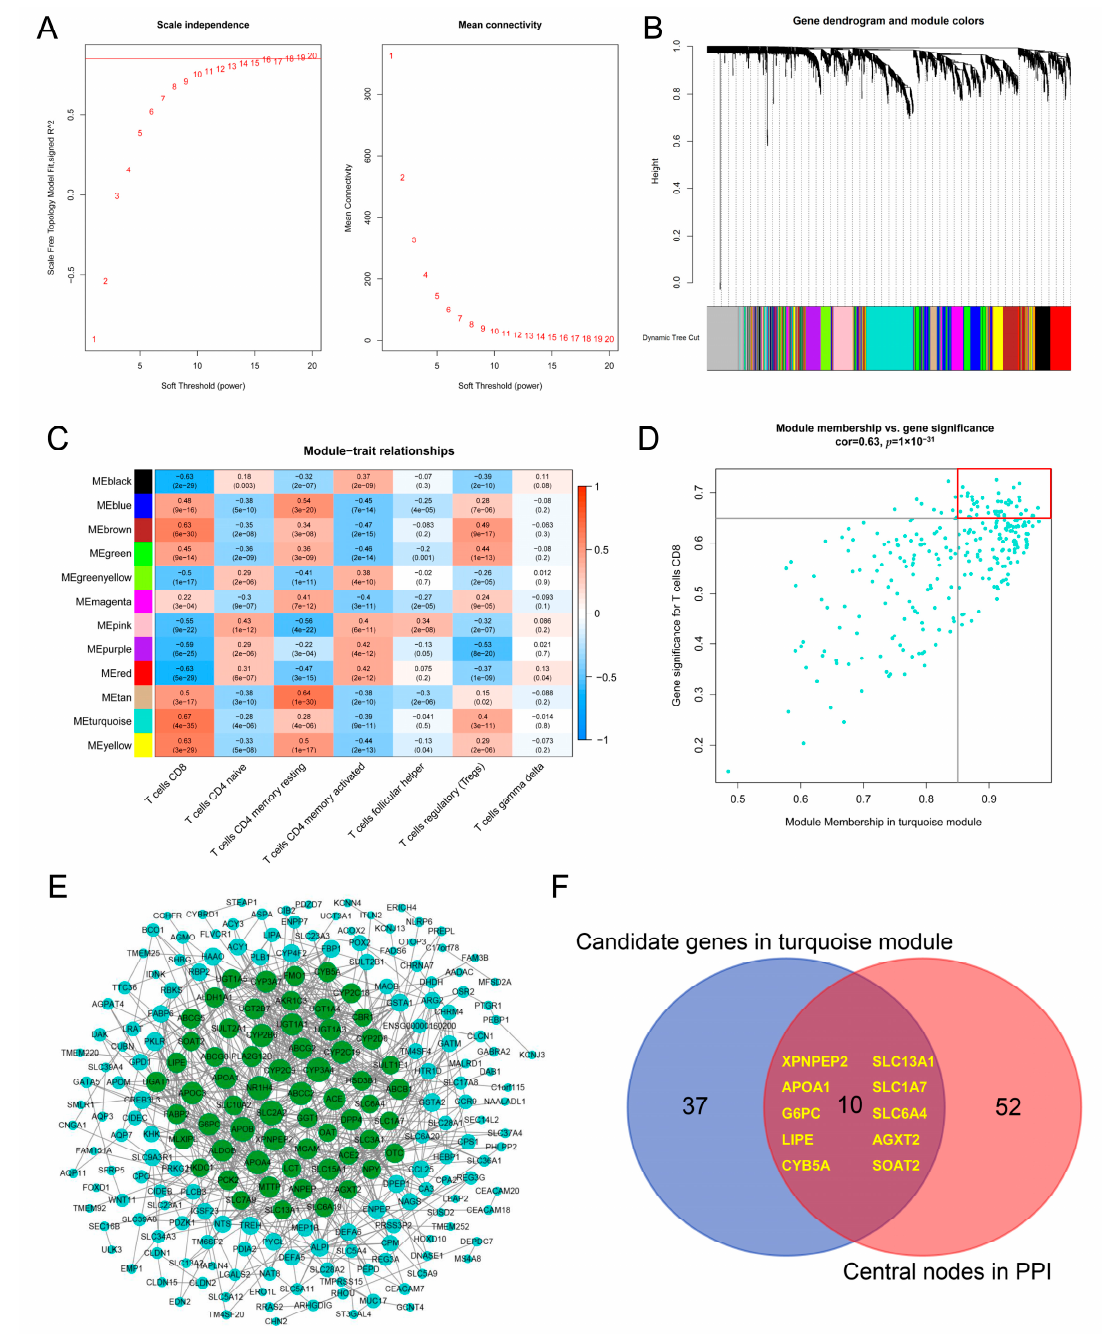
Figure 4. Hub module and hub genes related to CD8 + T cell infiltration in pediatric CD. ( A ). Left panel: the scale-free fit index ( y -axis) as the function of the soft thresholding power ( x -axis). Right panel: the mean connectivity ( y -axis) of 1–20 soft thresholding power ( x -axis). ( B ). The dendrogram of all DEGs clustered in different modules. ( C ). Heatmap of correlation analysis (Pearson’s correlation coefficient and p -value) between modules and eight T cell subtypes. ( D ). The scatter plot of each gene in the turquoise module. Dots in the red box represents genes of module membership >0.85 and gene significance >0.65. ( E ). Protein–protein interaction network of genes from the turquoise module. Nodes in green represent a central node. ( F ). Ten hub genes based on intersection between PPI and co-expression networks. WGCNA, weight gene-co-expression network analysis; PPI, protein– protein interaction.